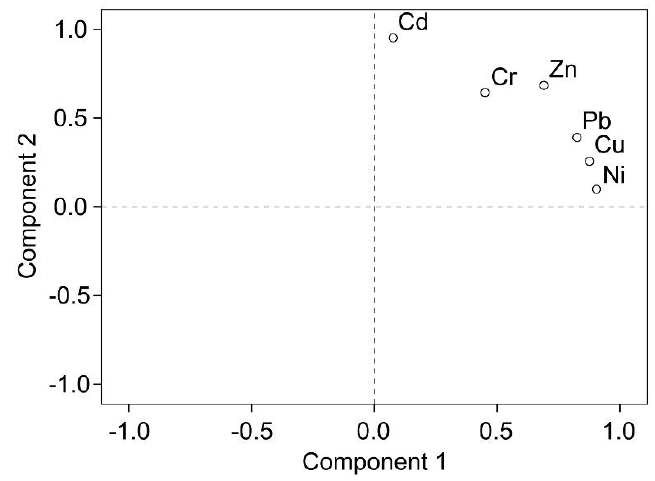
Figure 5. Plot of loading of two principal components in the rotated space.